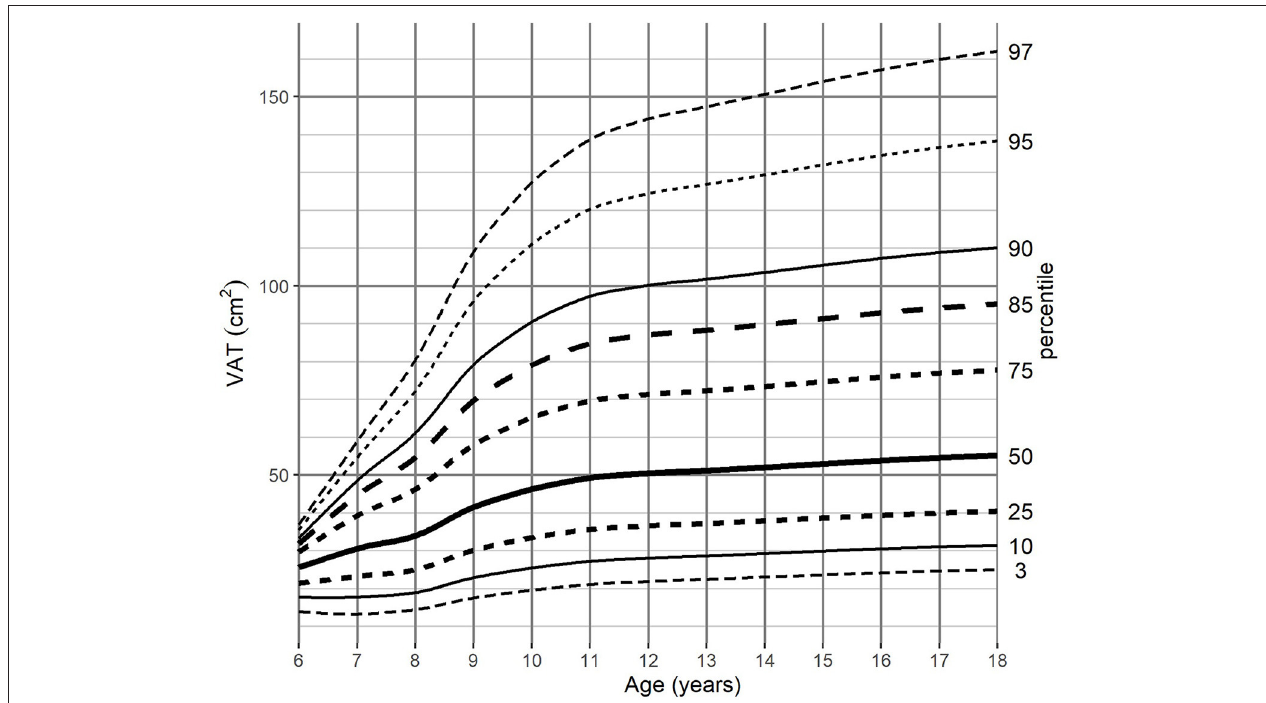
FIGURE 4 | VAT-for-age (cm 2 ) percentile charts for boys aged from 6 to 18 years. VAT, visceral adipose tissue.